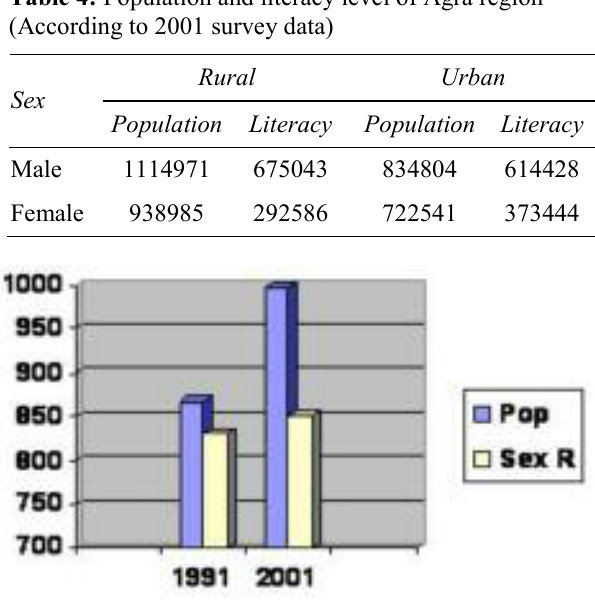
Table 4: Population and literacy level of Agra